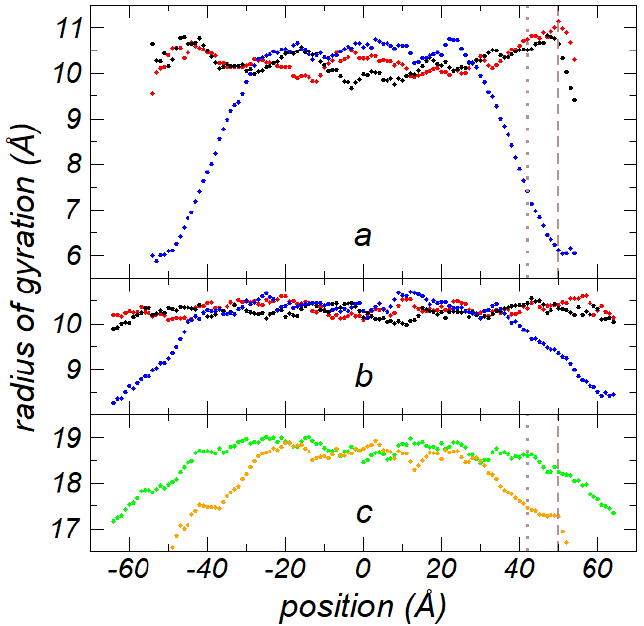
Figure 6. R g profiles as a function of the inhomogeneous position within the simulation cell at thickness layers wider than the corresponding t c for systems of 288 polyethylene chains (C 200 ) at T = 673.15 K, simulated using a r c of ( a ) 7.5 σ CH and ( b ) 2.5 σ CH . Black and red points 3 − CH 3 3 − CH 3 represent the lateral R g , while blue points represent the normal R g . ( c ) Total R g profiles for systems simulated using r c = 7.5 σ CH (orange) and r c = 2.5 σ CH (green). Vertical dashed and 3 − CH 3 3 − CH 3 dotted lines in ( a ) and ( c ) represent z Gds and z 90% ,